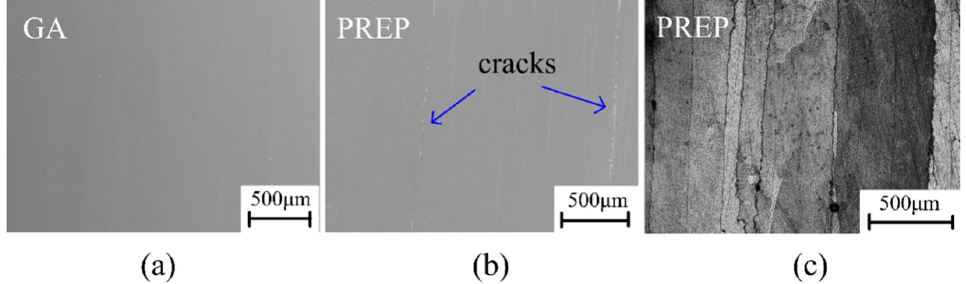
Figure 7. Crack morphology of as-EBM GH4099: optical micrographs of un-etched ( a ) GA sample with no cracks and ( b ) PREP sample with cracks parallel to the building direction. ( c ) Etched PREP sample showing the microcracks are intergranular cracks.